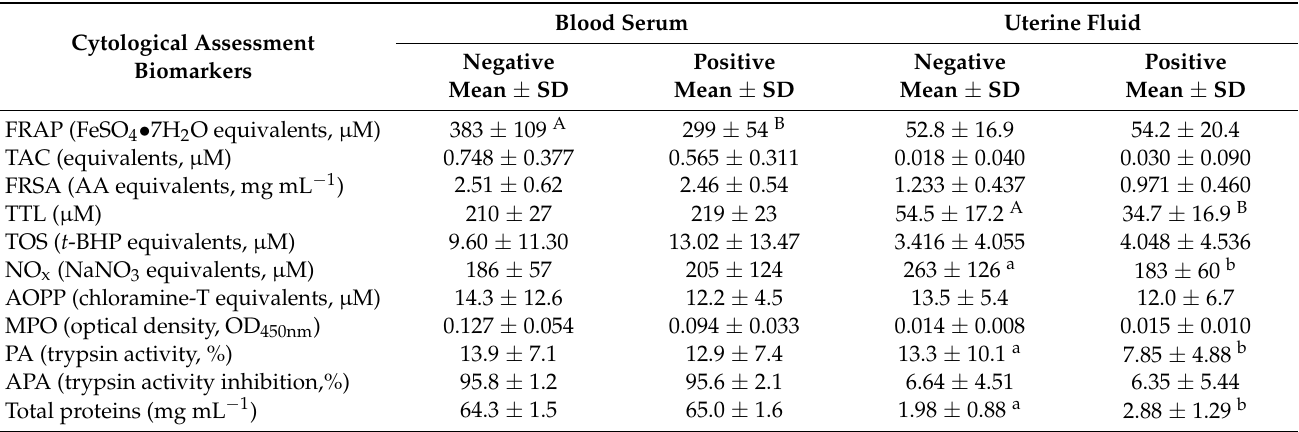
Table 2. Mean ( ± SD) values of oxidative, inflammation, and protease regulator biomarkers assessed in the blood serum and the uterine fluid of mares with negative (n = 9) and positive (n = 24) outcomes for the diagnosis of endometritis based on cytological assessment.